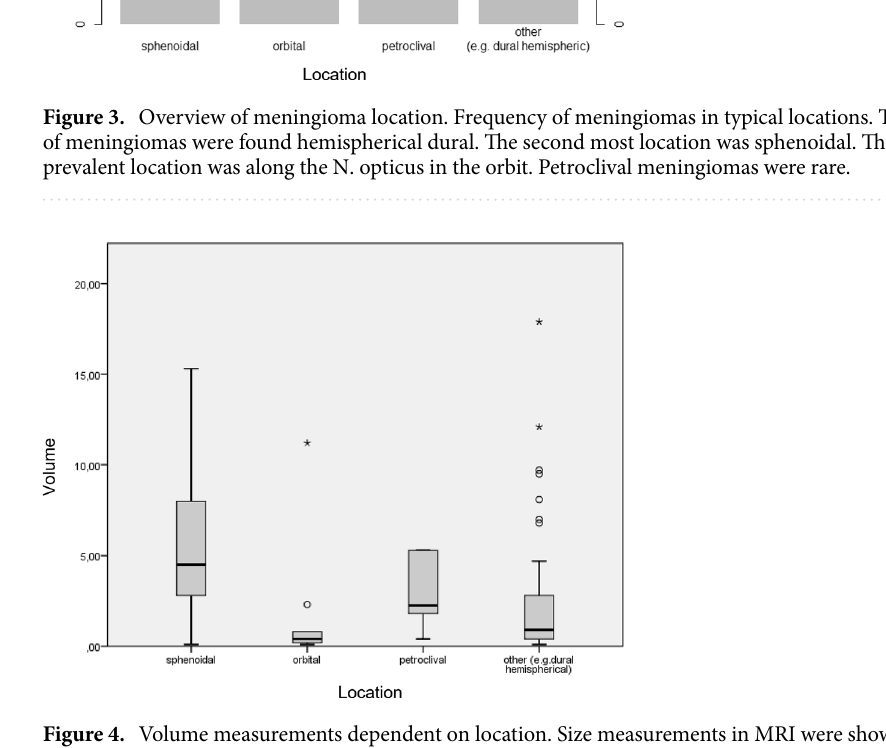
Figure 4. Volume measurements dependent on location. Size measurements in MRI were shown highest values for sphenoidal meningiomas. The highest measurement is 48.4 cm 3 was sphenoidal (not included in the diagram due to scale reasons). The smallest sizes were measured for optical sheat